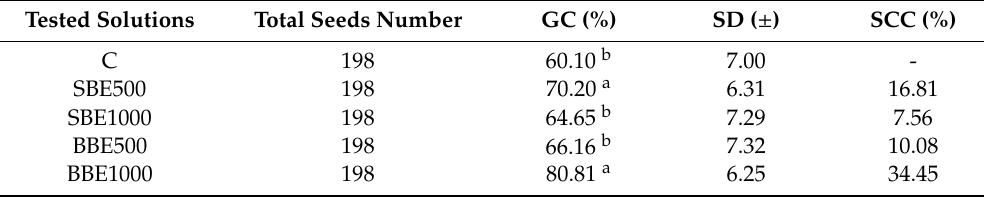
Table 1. The influence of bark extracts on lavender seed germination capacity.